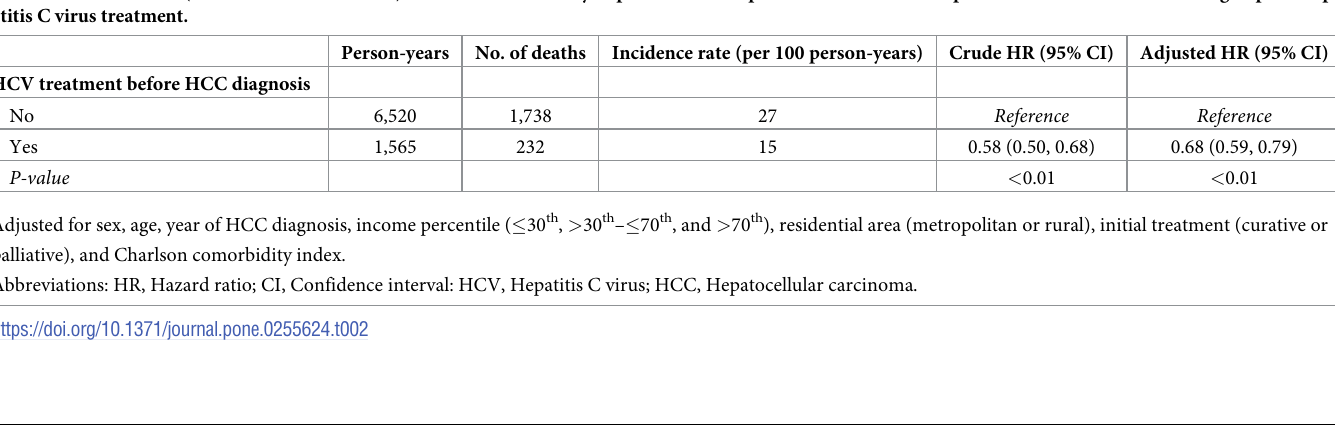
Table 2). After adjusting for sex, age, year of HCC diagnosis, income percentile ( � 30 th , > 30 th – � 70 th , and > 70 th ), residential area (metropolitan or rural), initial treatment (curative or palliative), and CCI, the HR (95% CI) for all-cause mortality when comparing patients with and without prior antiviral treatment was 0.68 (0.59, 0.79) (Table 2). The association between prior antiviral treatment and decreased all-cause mortality was observed in all the subgroups analyzed (Fig 4); however, the association was stronger for the factors of age � 65 years, female sex, CCI 0–1, and curative treatment as compared to age < 65 years, male sex, CCI score � 2, and no treatment or palliative treatment.